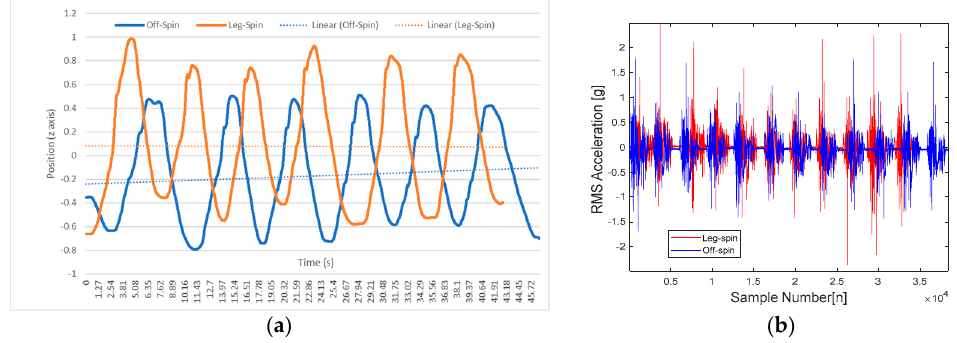
Figure 7. Linear classification model for off-spin and leg-spin bowlers: ( a ) motion capture; ( b ) root mean square (RMS) acceleration of the bower’s lumbar (T3) using IMU sensors sampled at 250 Hz.